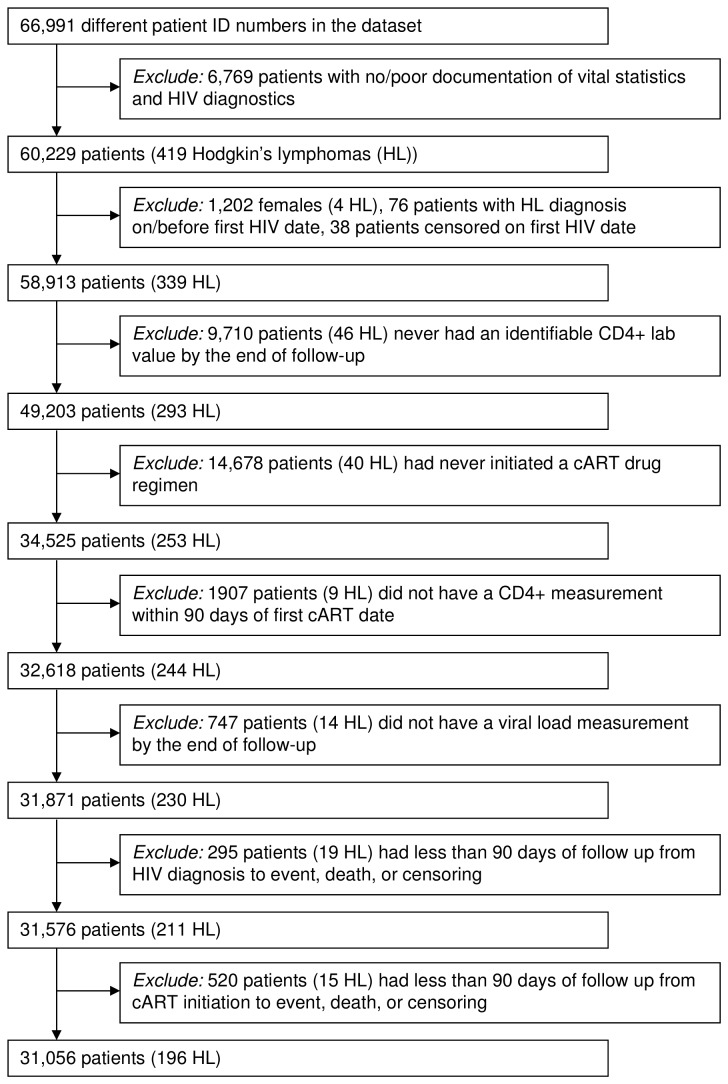
Flow chart of selection criteria to generate final cohort of HIV-infected veterans.